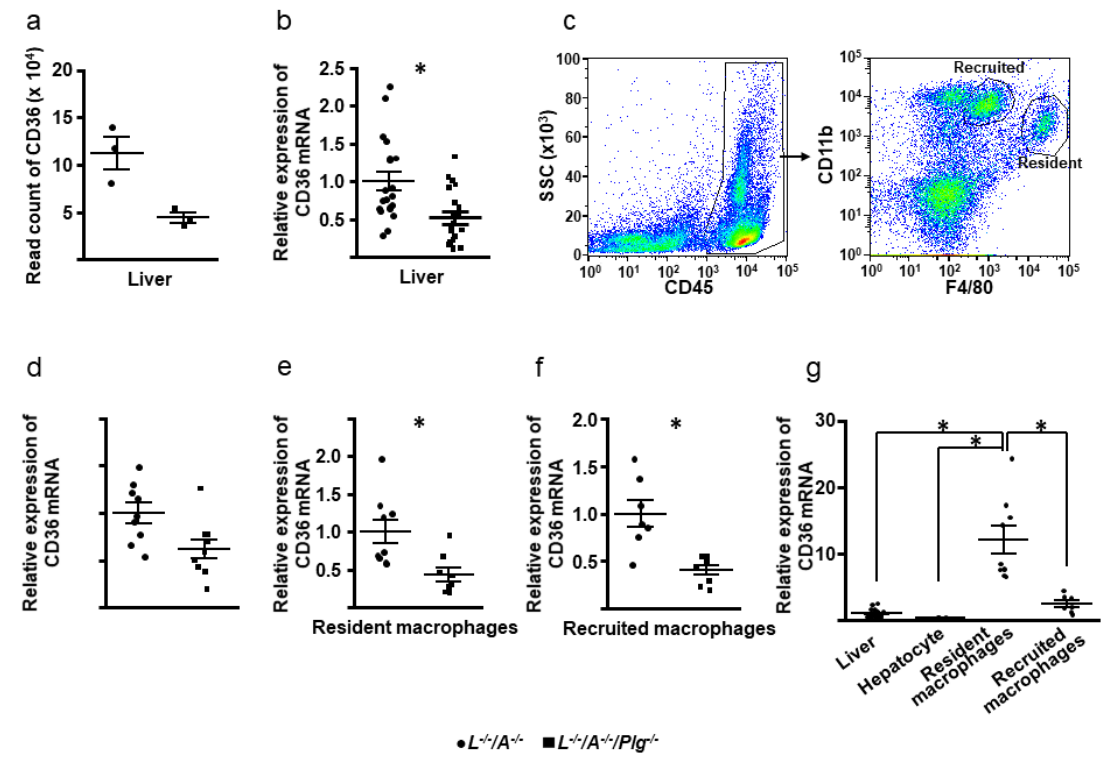
Figure 6. ( a ) Read count of Cd36 by RNA sequencing ( n = 3). ( b ) The mRNA expression levels of Cd36 in liver ( n = 20). ( c ) CD45+ cells were analyzed with F4/80 and CD11b, and resident (F4/80hi) and recruited (CD11bhi) macrophages were sorted. ( d – f ) The mRNA expression levels of Cd36 in hepatocytes and recruited and resident macrophages ( n = 7–9). ( g ) Comparison of the mRNA expression levels of Cd36 in liver, hepatocytes, and recruited and resident macrophages in L − / − /A − / − mice ( n = 7–20). * p < 0.05 between L − / − /A − / − and L − / − /A − / − /Plg − / − in ( b , e , f ). In ( g ), between the pairs of comparisons.